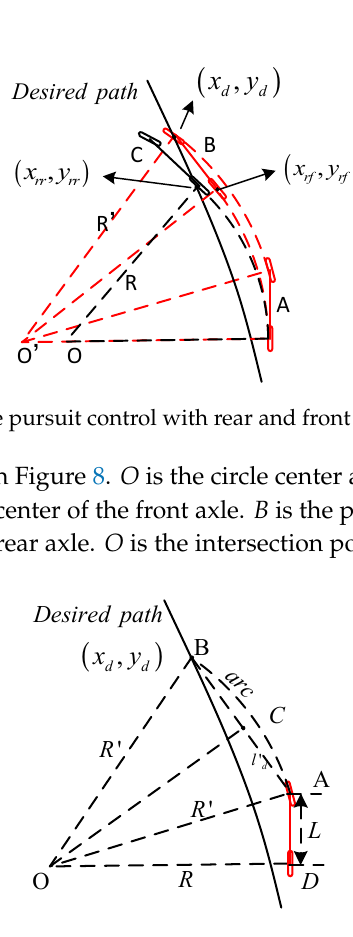
Figure 8. Pure pursuit control with a front axle reference.